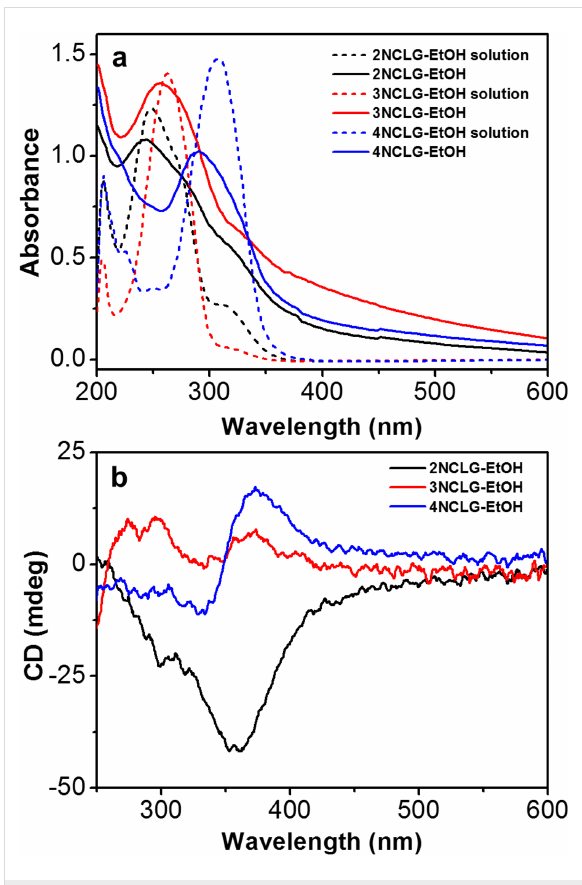
Figure 3: (a) UV–vis spectra of 2NCLG, 3NCLG, 4NCLG ethanol solu- tions and self-assembled molecules. (b) CD spectra of 2NCLG, 3NCLG and 4NCLG self-assembled